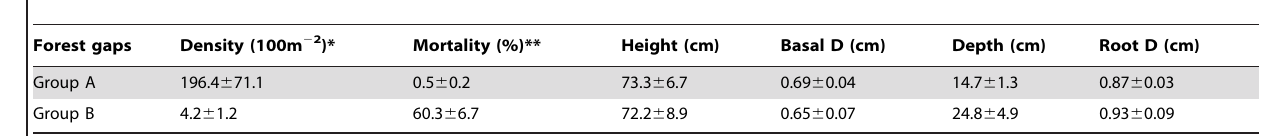
Table 3. Growth characteristics of two groups of P. euphratica root suckers in forest gaps.